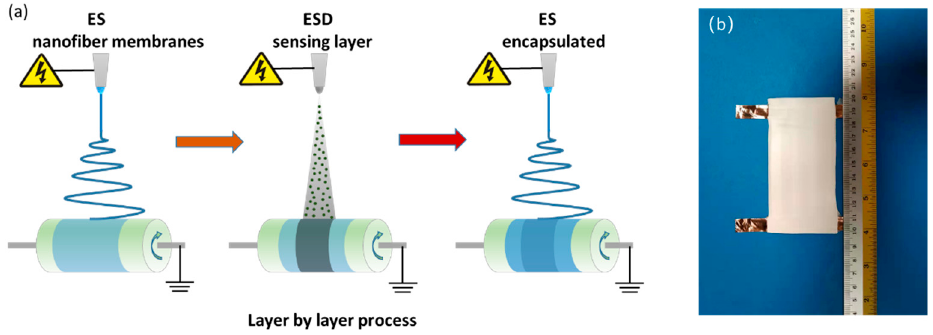
Figure 3. ( a ) Schematic illustration of the fabrication process of the strain sensor; ( b ) Photographs of an ESD-ES strain sensor.